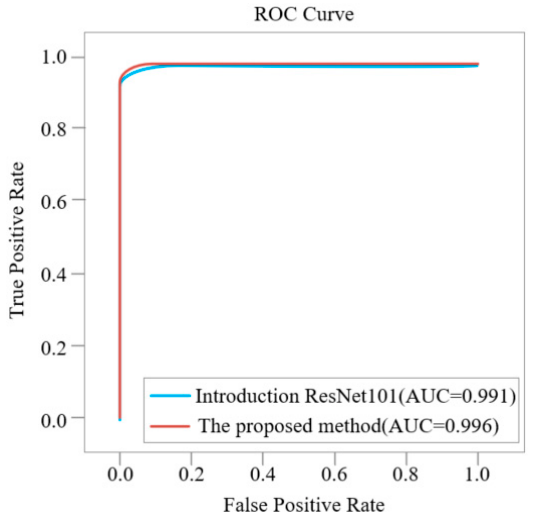
Figure 12. Comparison of ROC curves on the OCT image test set of the different two improved models.